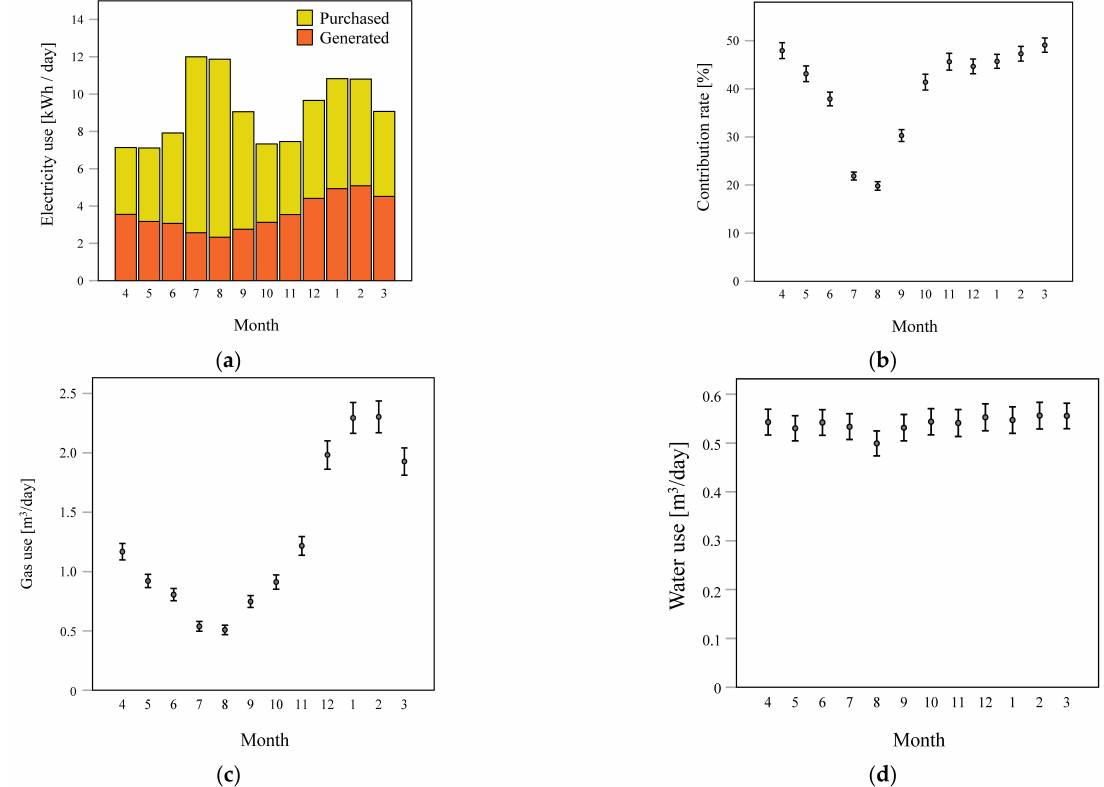
Figure 8. Monthly variation (n = 304): ( a ) electricity use; ( b ) contribution rate; ( c ) gas use (except for CGS); ( d ) water